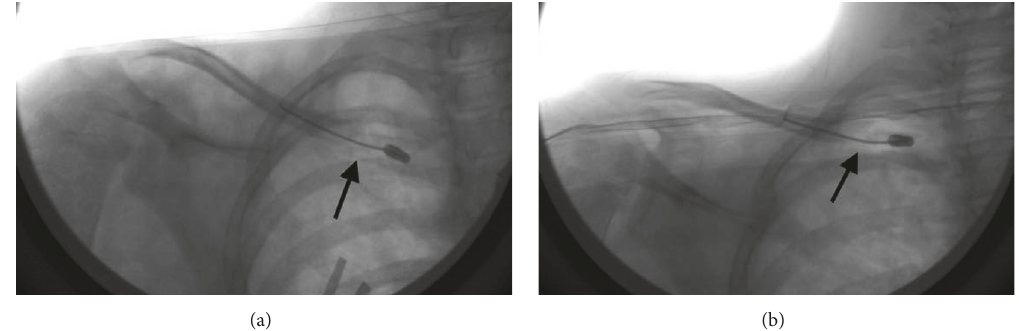
Figure 2: (a) Intraoperative AP view and (b) AP cephalic tilt view of the right medial clavicle. The black arrow indicates the site of fracture.